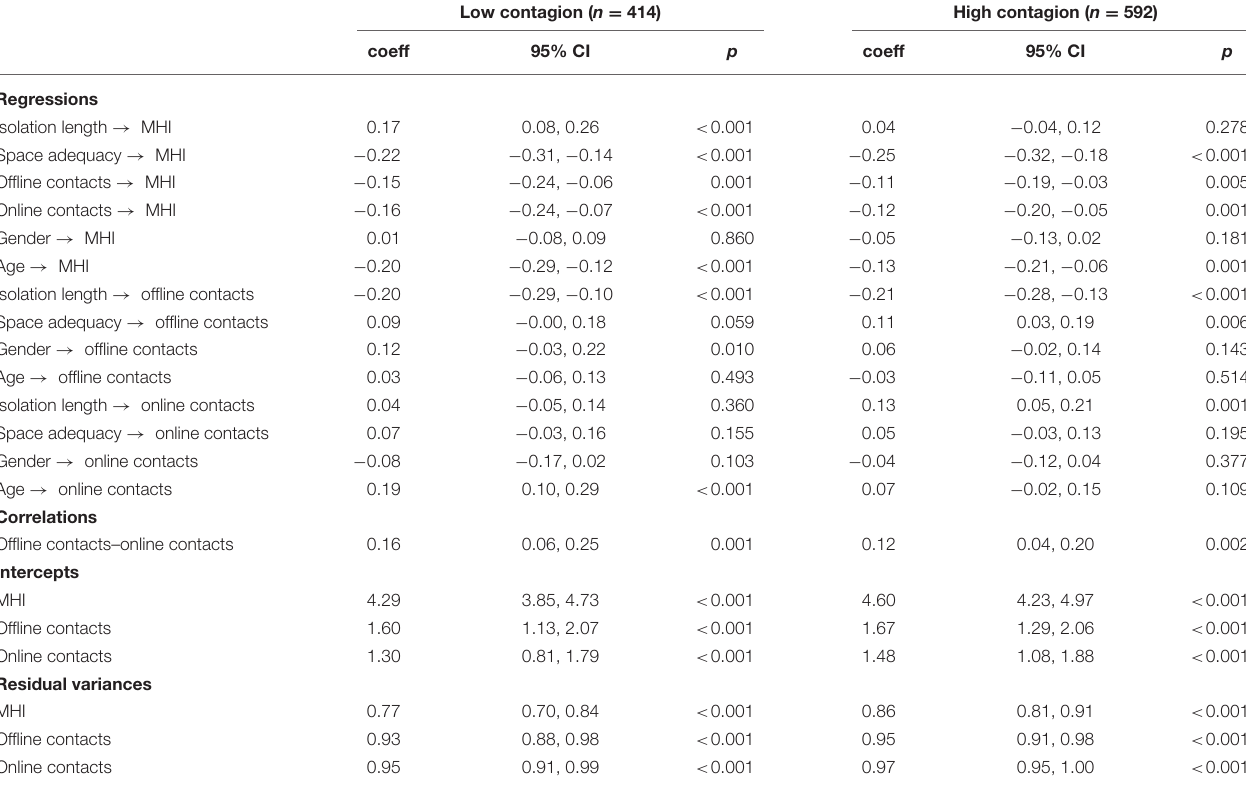
TABLE 2 | The results of the multi-group path analysis: standardized regression coefficients and 95% CIs are reported. Low contagion ( n =